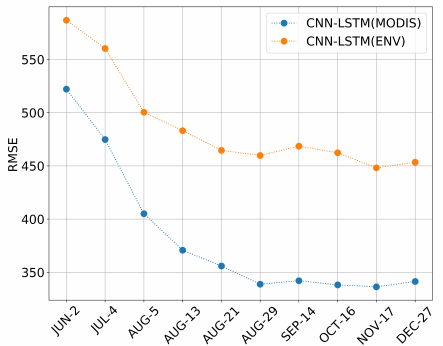
Figure 11. Performance of different type of